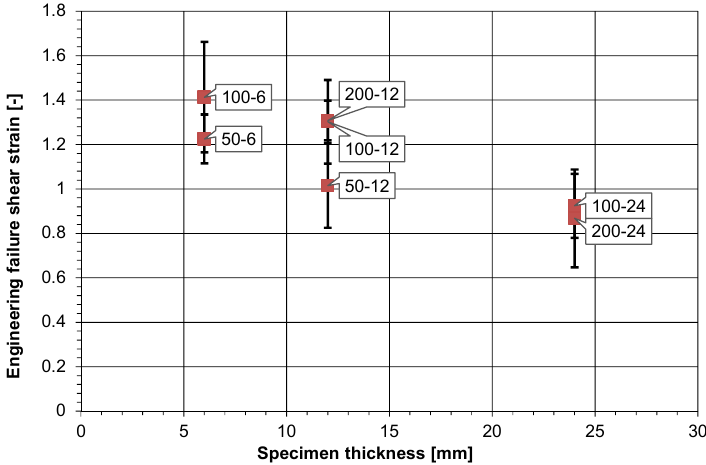
Fig. 26 Engineering strains at failure plotted against the thichness of the specimen. The error bars indicate the standard deviation for each test